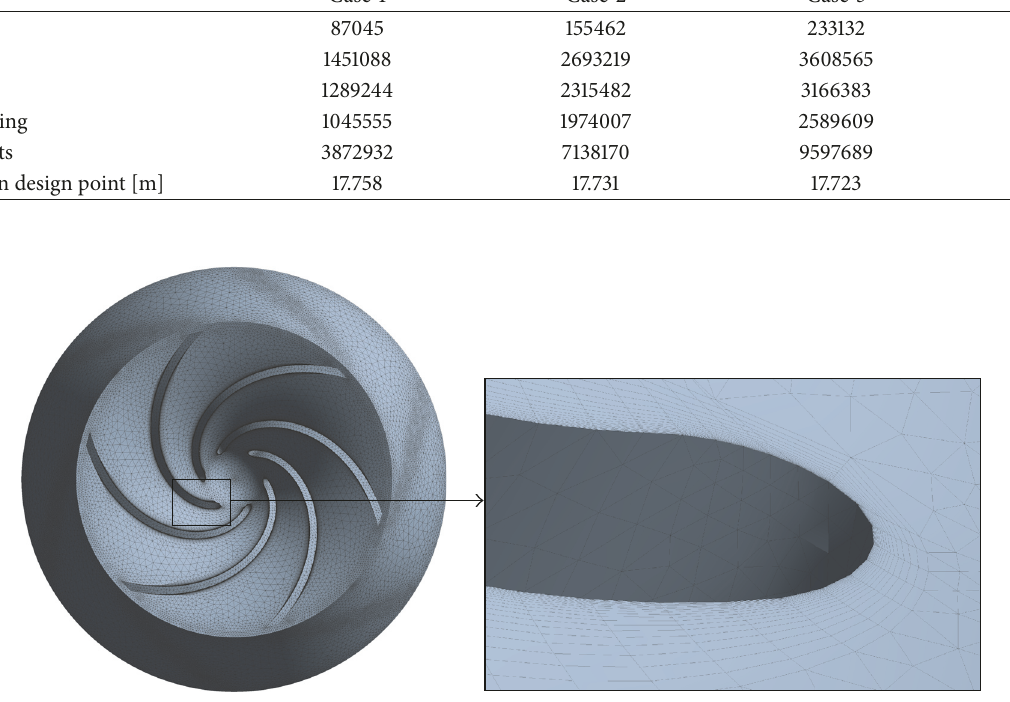
Figure 2: The mesh of the impellers and partial